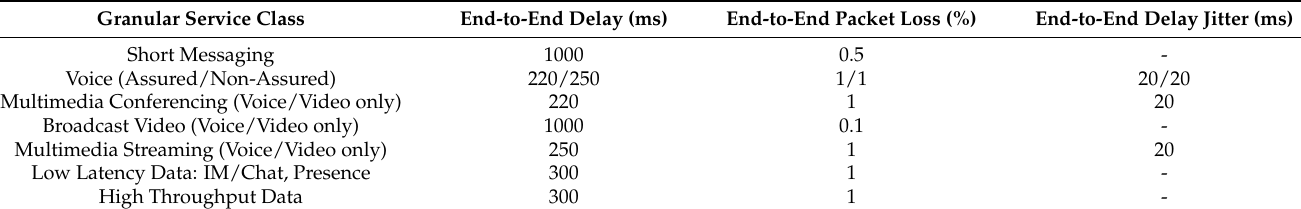
Table 1. Granular service performance objectives.